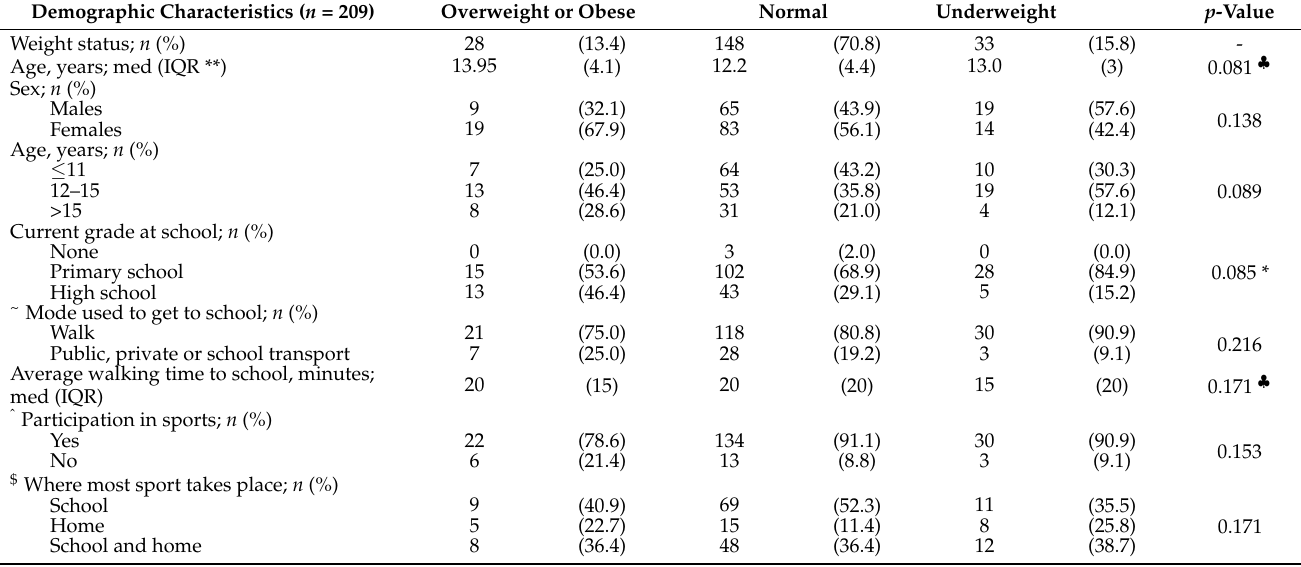
Table 1. Demographic characteristics and lifestyle of children and